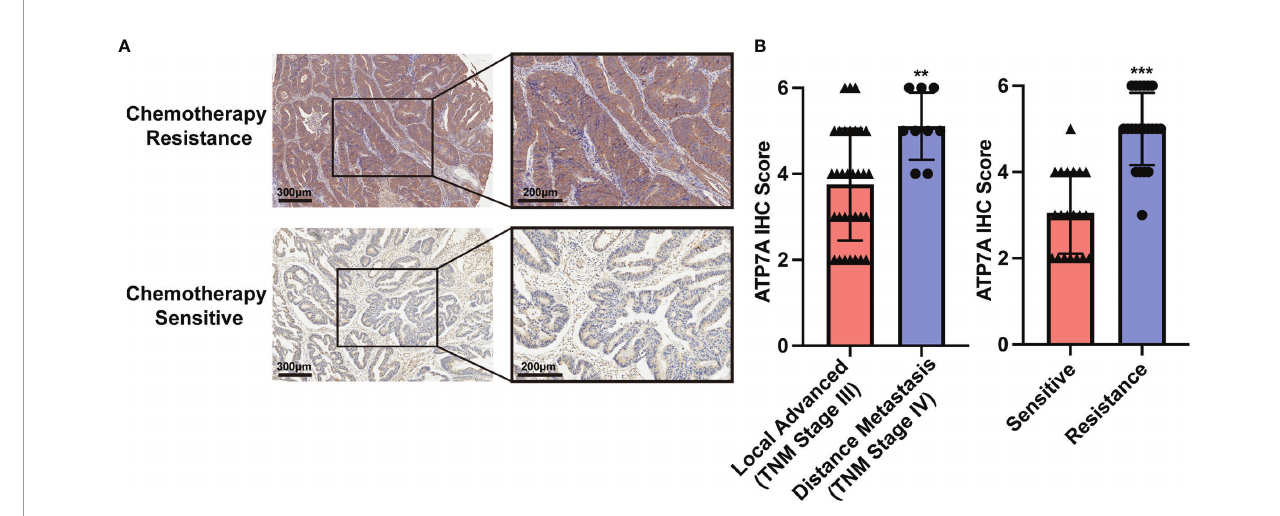
FIGURE 1 | Implications of ATP7A expression and clinical characteristics. (A) Expression of ATP7A in OXA resistance and OXA responder of CRC patients. (B) IHC staining scores of chemotherapy resistance patients and chemotherapy responders. **P < 0.01 and ***P < 0.001 when compared to the control